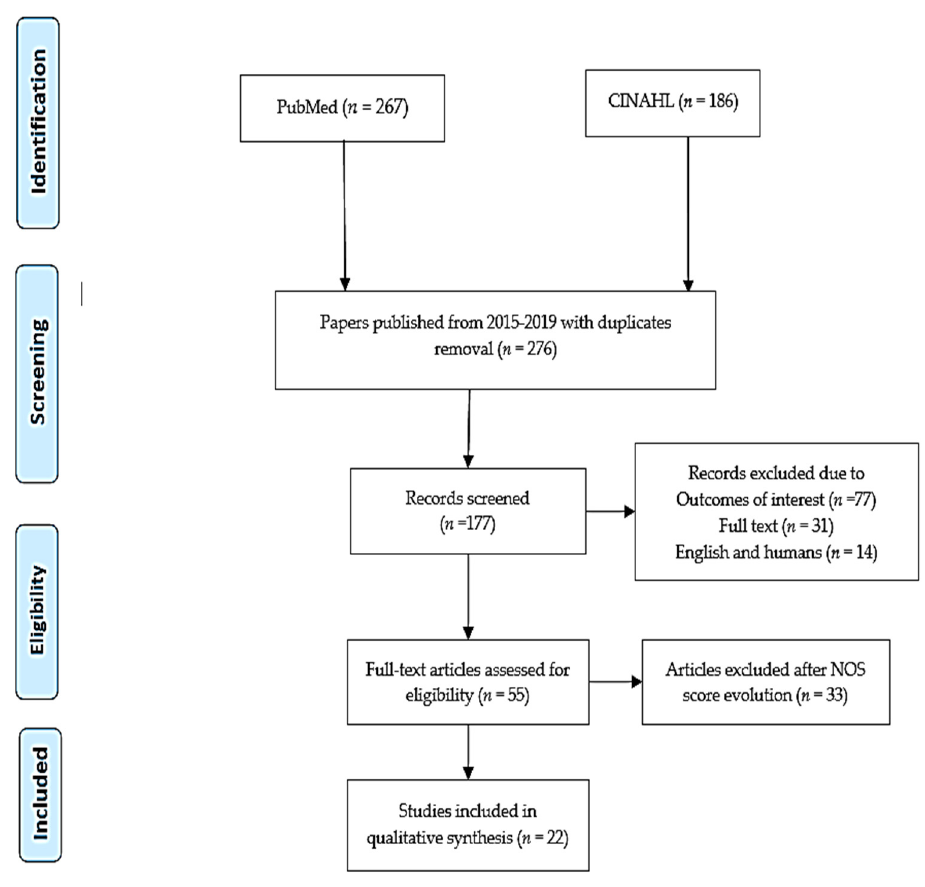
Figure 1. Preferred reporting items for systematic reviews and meta-analyses (PRISMA) diagram [15] . Table 1. Machine learning (ML) algorithms on different pathologies along with input features and outcomes measures.